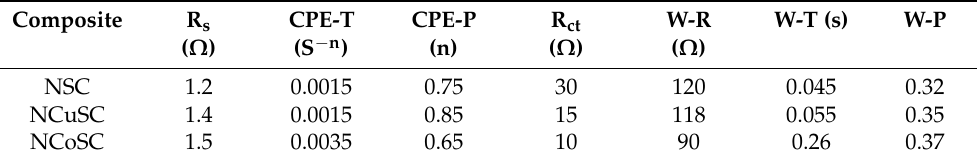
Table 1. Fitted values of R s , R ct , CPE-T, CPE-R, W–R, W–T, W–P from the equivalent circuit corre- sponded to Figure